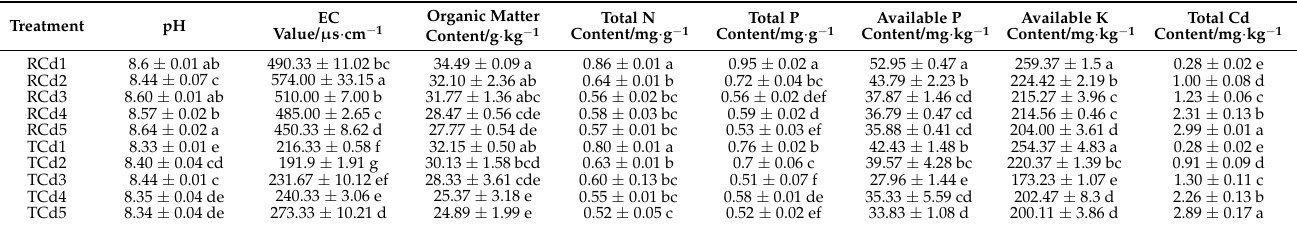
Table 3. Physical and chemical properties of soil used in treatment.